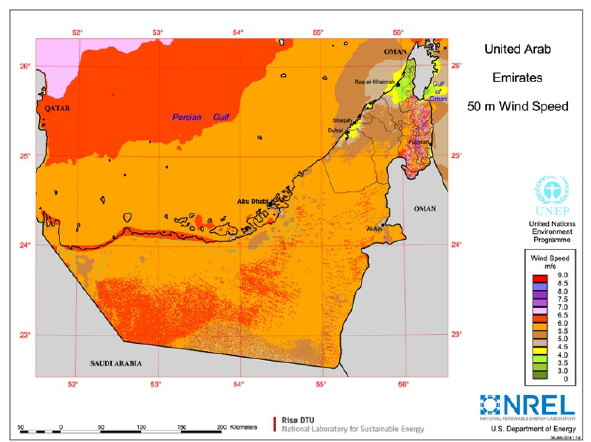
Figure 2: Mean wind speed at 50 m over UAE (source: NREL)